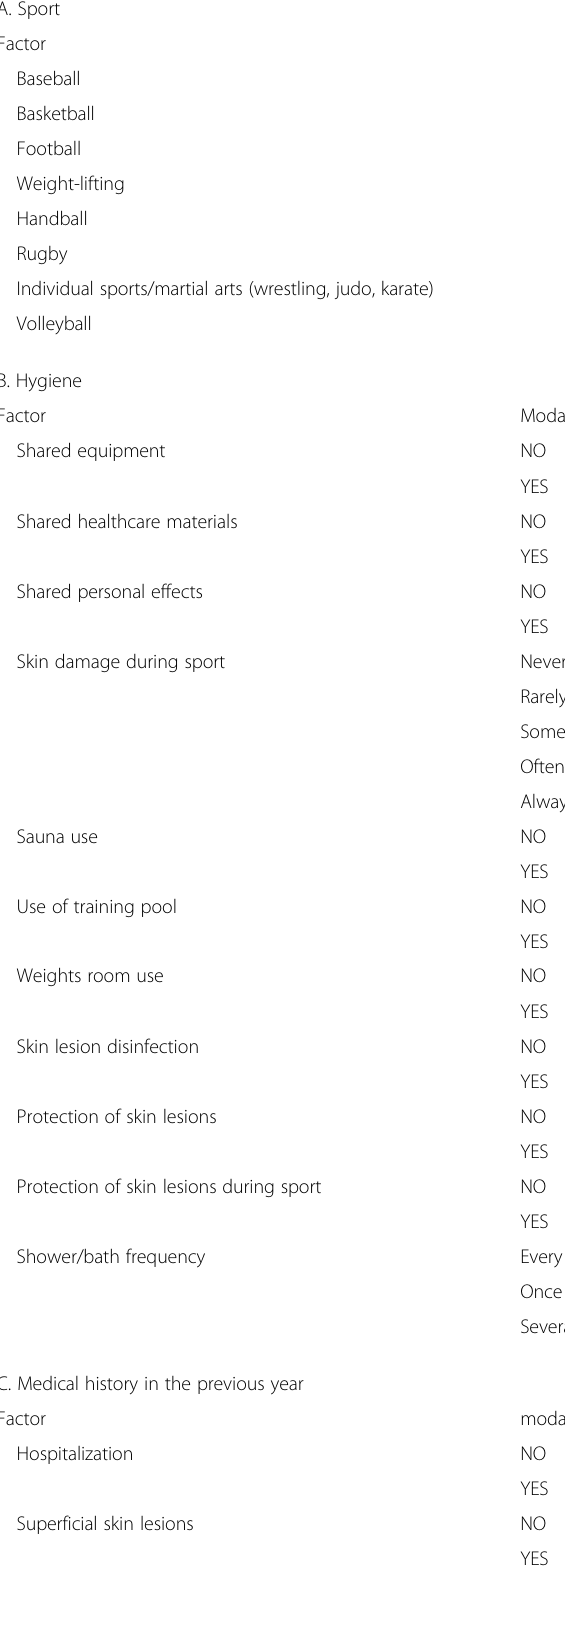
Table 3 Risk Factors of the